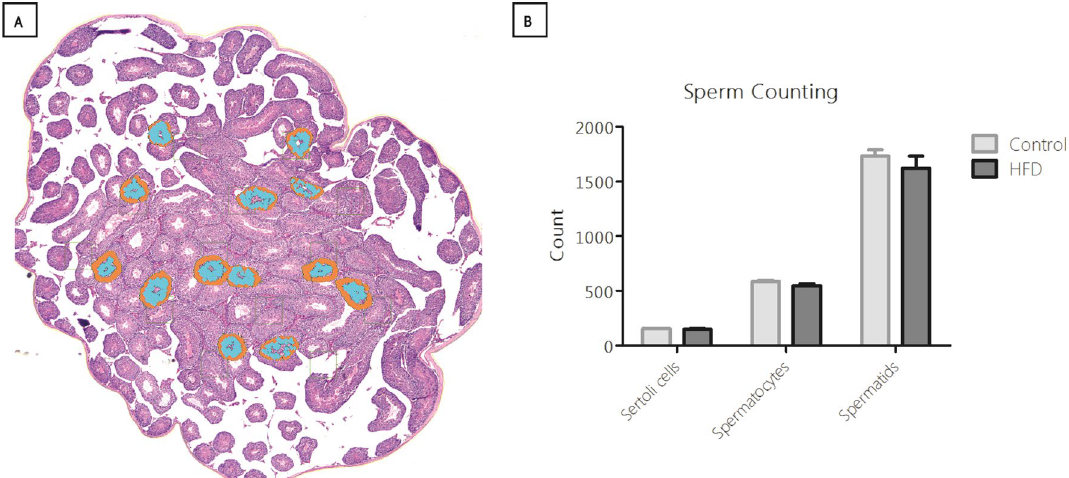
Figure 2. Analysis of sperm cells and Sertoli cells. ( A ) Overview of the analysis in one section, per testis four randomly selected sections were counted. Magnification × 25. ( B ) Quantification of Sertoli cells, spermatocytes, and spermatids per testis. Control n = 10. HFD n = 10.